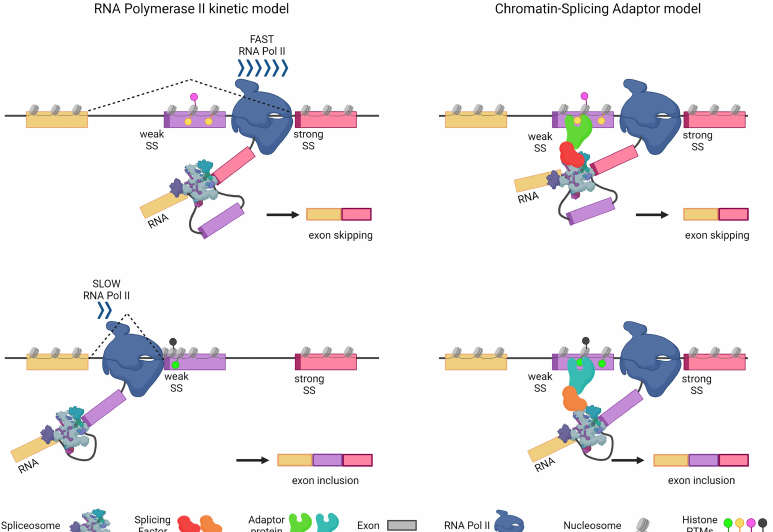
Figure 1. Two non-exclusive models describe how transcription and alternative splicing are func- tionally coupled. Left: In the context of the Kinetic Coupling Model, the rate of transcriptional elongation, influenced by different histone PTMs, affects AS outcome. At high RNA polymerase II (RNA Pol II) elongation rates, there is a brief temporal window in which weak (purple) and strong (pink) splice sites (SS) compete for the recruitment of the splicing machinery, resulting in the skipping of the weaker exon (purple rectangle). On the contrary, exon inclusion is favored by RNA Pol II slowing down or pausing, which facilitates the recognition of the weak SS before the strong SS is synthesized. Right: According to the Chromatin-Adaptor Model, histone-PTMs changes along the gene (marked in different colors) determine the recruitment of specific adaptor proteins, which, in turn, recruit splicing factors and the transcription machinery, hence influencing AS decisions. Created with